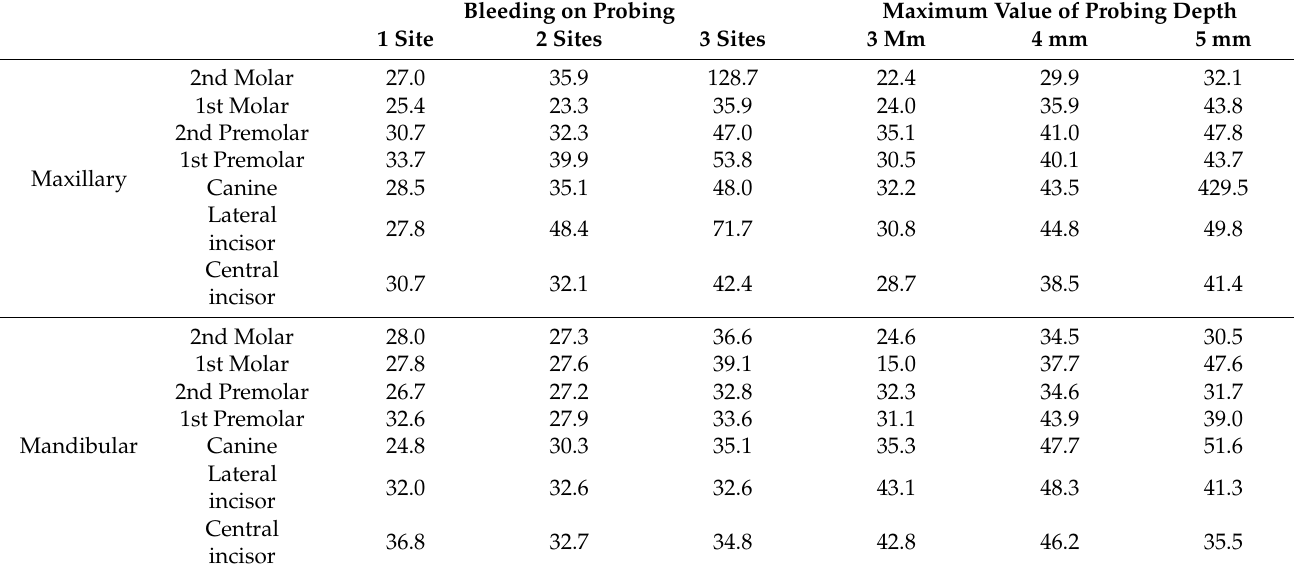
Table 1. Item information for tooth type for the number of bleeding sites and the maximum value of probing depth. Bleeding on Probing Maximum Value of Probing